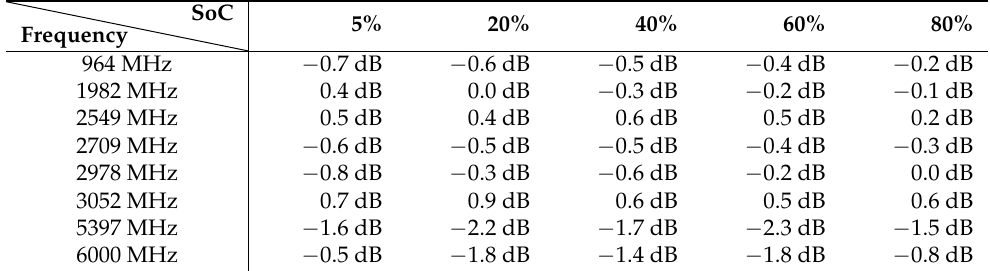
Table 1. Change in S21 magnitude (in dB) with SoC at selected frequencies using a baseline of 95%